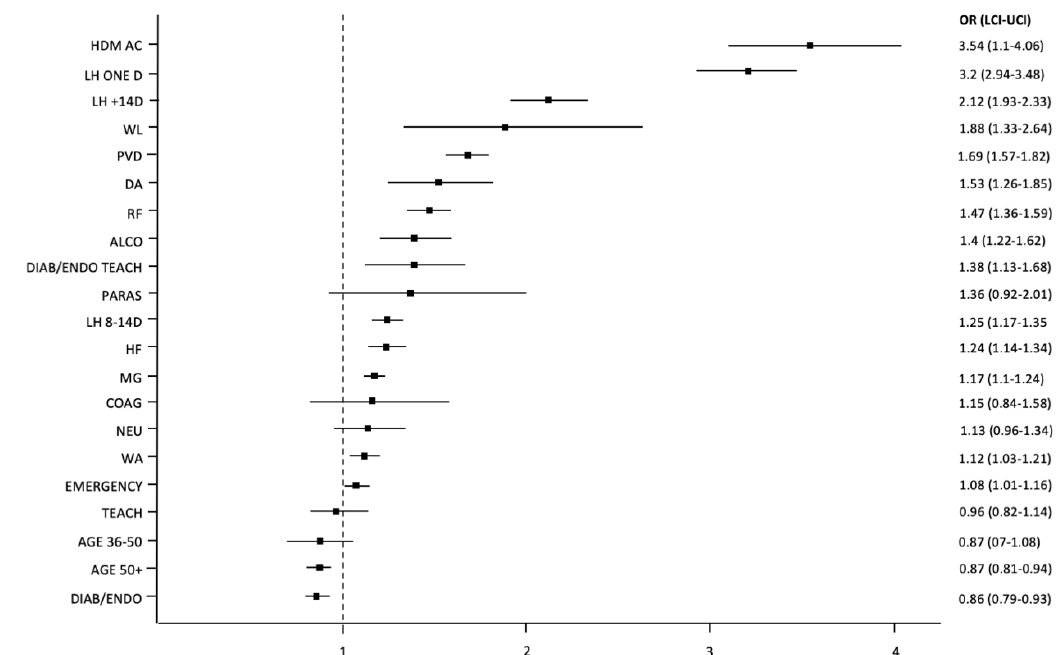
Figure 2. Odds ratios with 95% confidence intervals (represented by bars) for the variables used in the model that